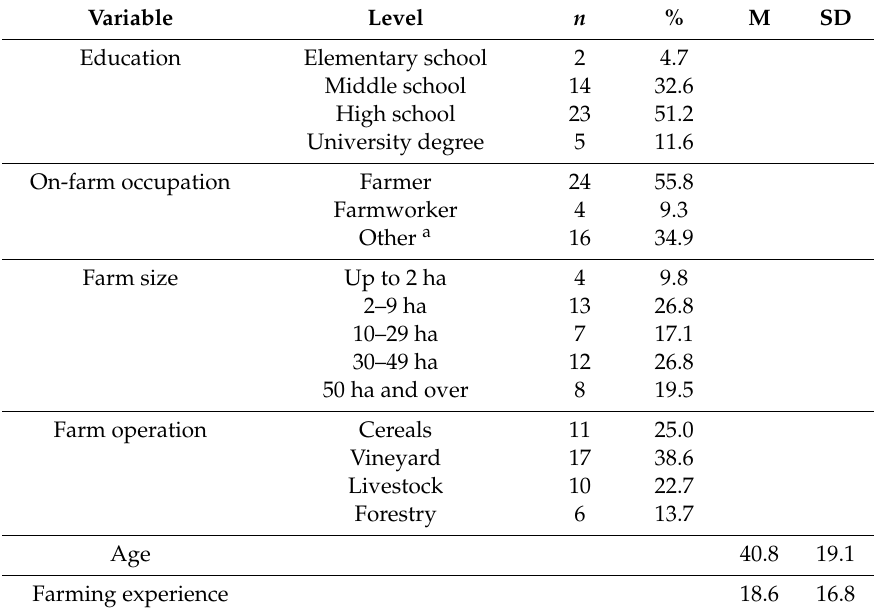
Table 1. Descriptive statistics of the sociodemographic characteristics of the participants. Variable